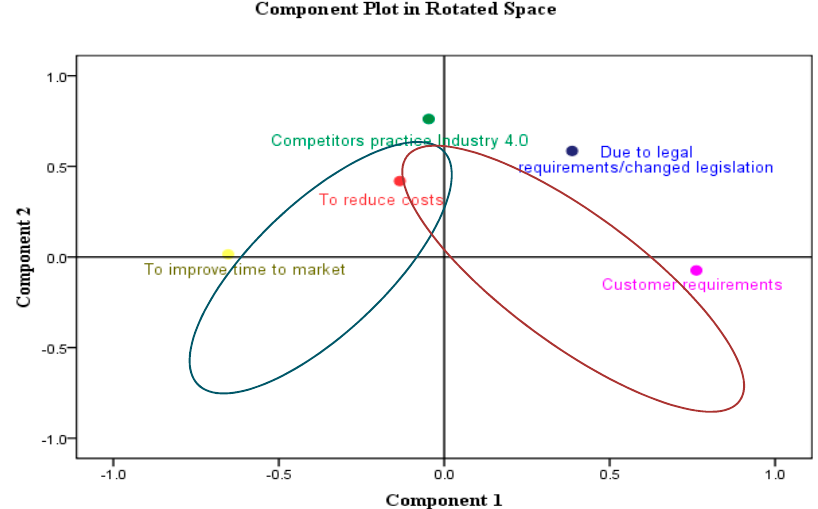
Figure 3. Graphical representation of the association between the 5 variables and the main components.